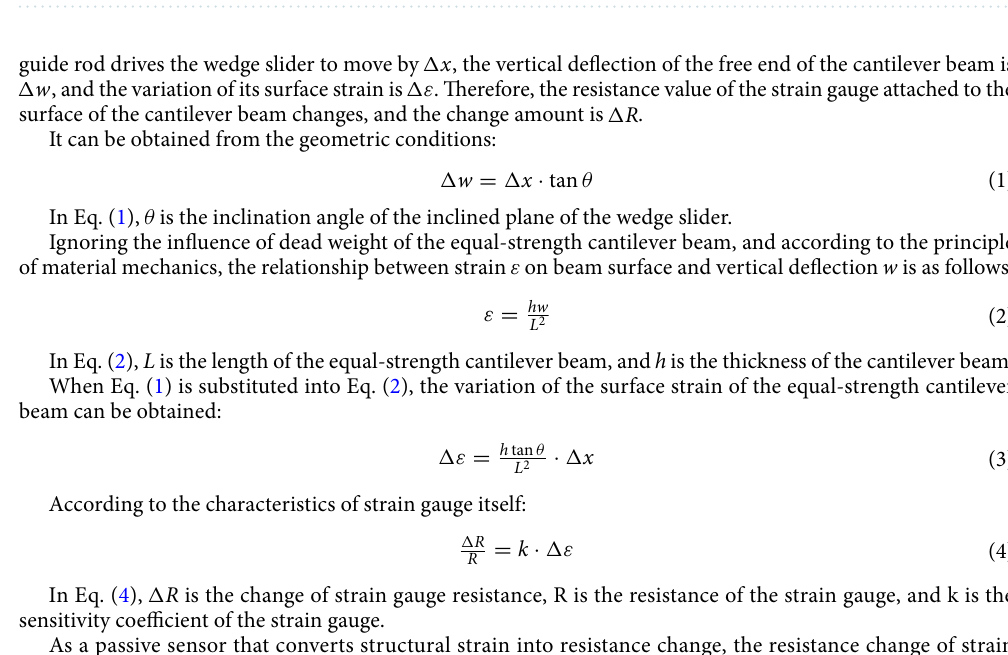
Figure 2. Geometric diagram inside the sensor (The figure was generated by Microsoft Visio Professional 2016 (https:// www. micro soft. com/ zh- CN/ downl oad/ detai ls. aspx? id= 51188)).